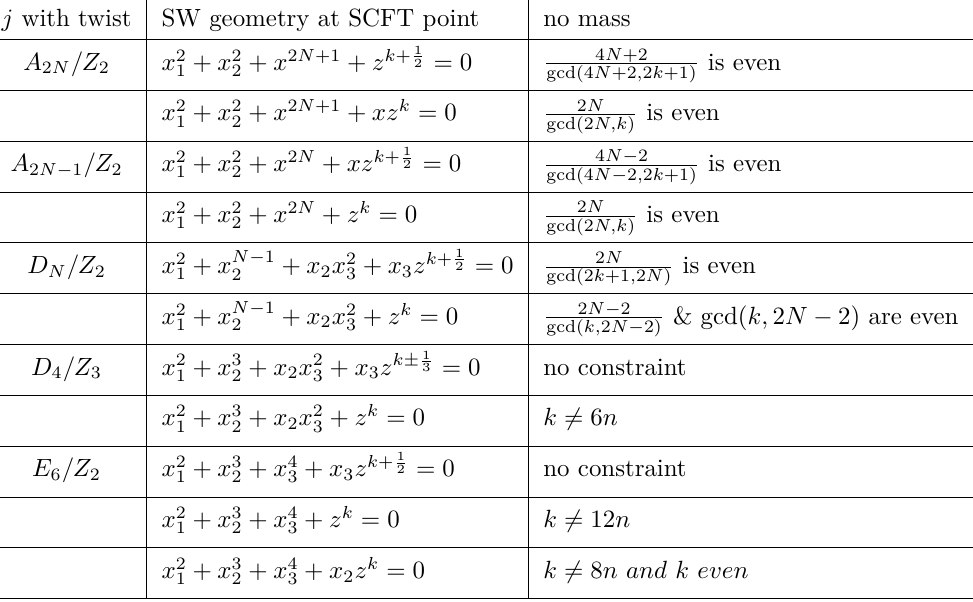
Table 6 . Constraint on twisted irregular singularity which does not have mass